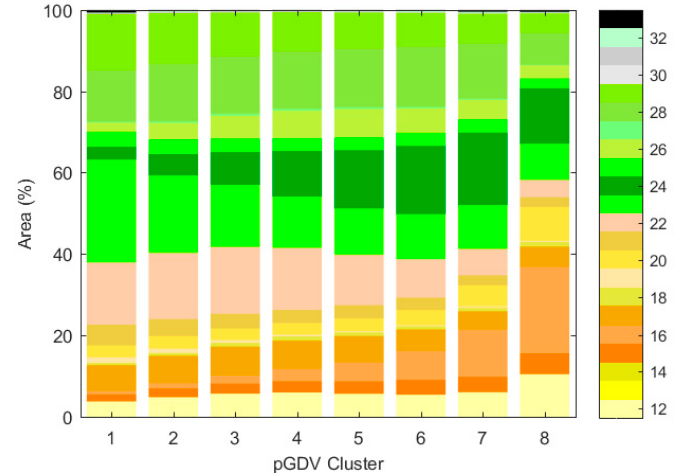
Figure 7. Area of CLC 2006 land cover types composing each GDV cluster, as the percentage of the area of each cluster. Color code is presented in Table